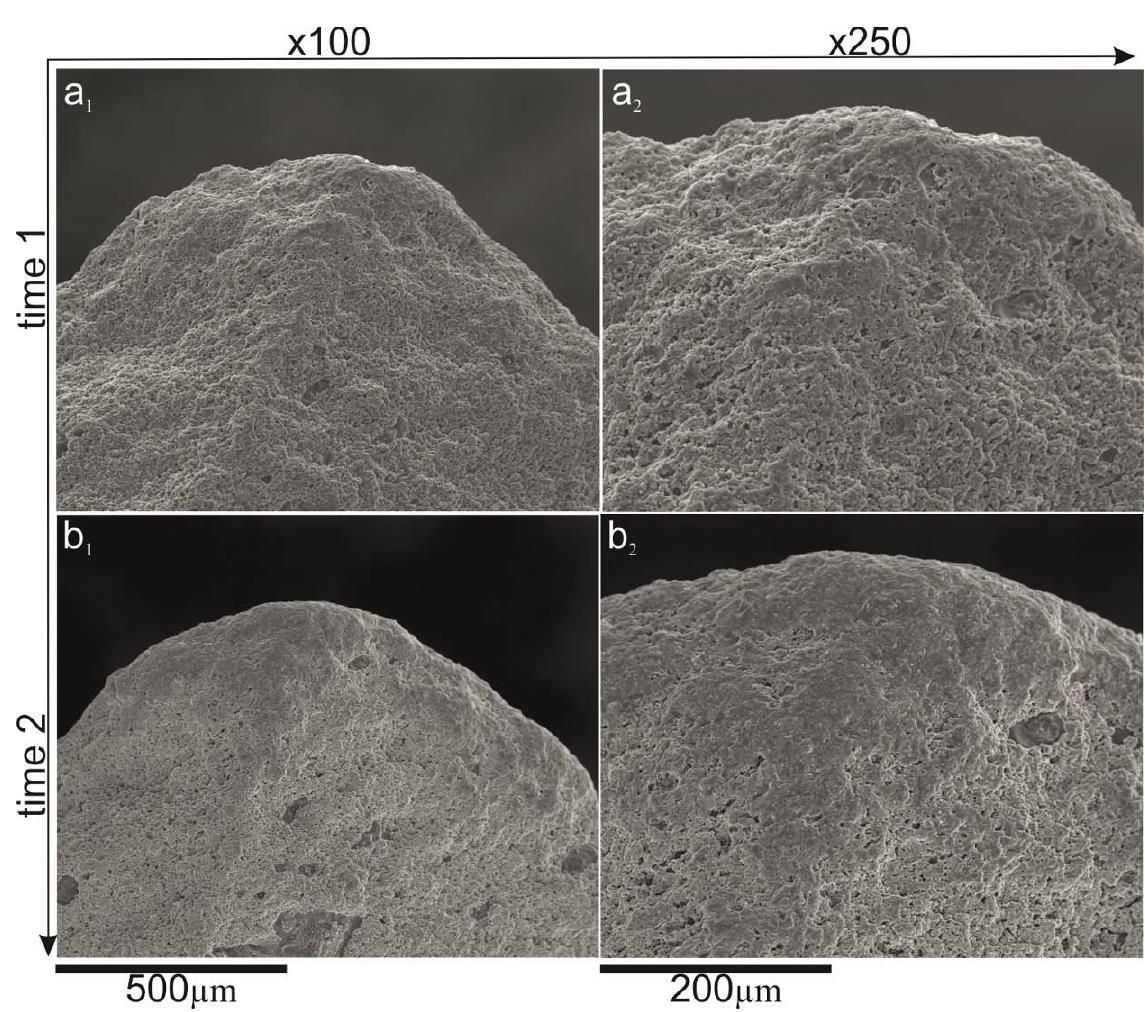
Fig.11 – Edge alteration after trampling and tumbling experiments that is similar to the functional traces seen under the SEM at x100 & x250 magnifications: a trampling showing some slight rounding and abrasion; b with more developed